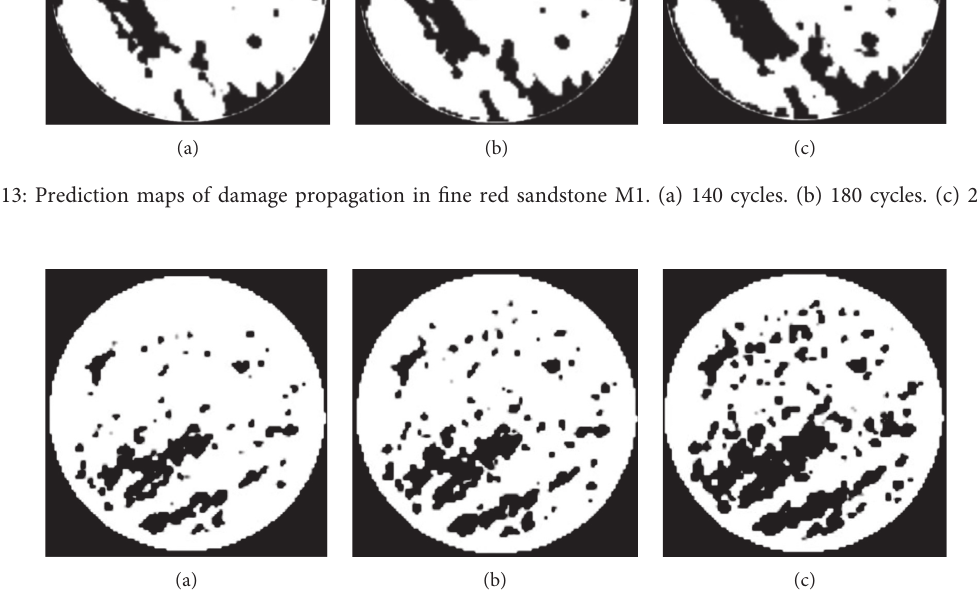
Figure 14: Prediction maps of damage propagation in coarse red sandstone A1. (a) 140 cycles. (b) 180 cycles. (c) 200 cycles. Table 2: Damage variables and number of damage regions.